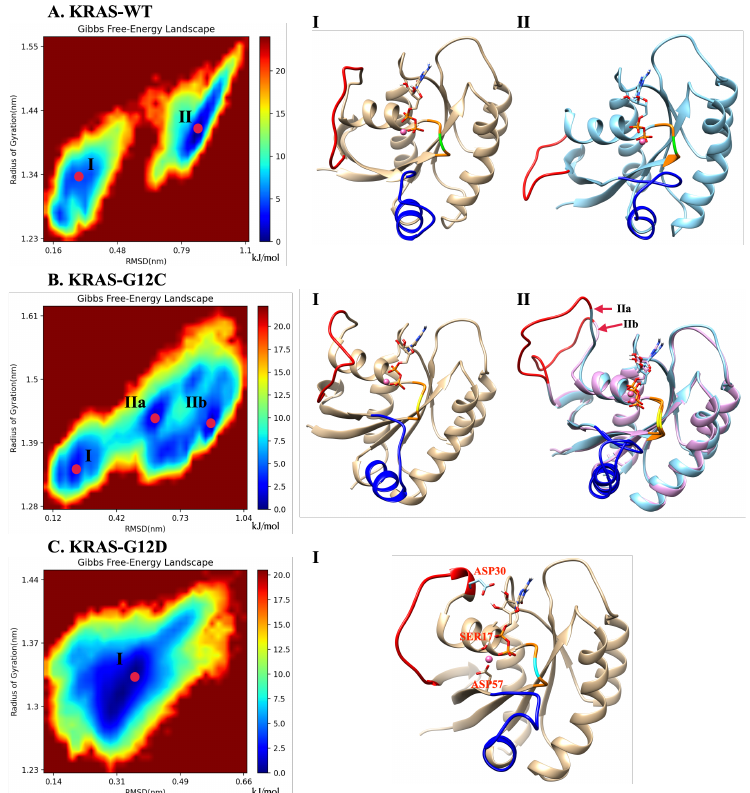
Figure 2. Gibbs free energy landscapes and representative conformations: ( A ) landscapes of the KRAS-WT-GDP-Mg 2 + complex and the representative dominant conformations of basins I and II; ( B ) landscapes of KRAS-G12C-GDP-Mg 2 + complex and the representative dominant conformations of basins I and II; ( C ) landscapes of the KRAS-G12D-GDP-Mg 2 + complex and the single representative dominant conformation (I). Selected groups: backbone atoms of residue 10 to 72; GDP and the Mg 2 + binding on KRAS. Red: SW-I; Blue: SW-II; Orange: P-loop; Green: GLY12; Yellow: CYS12; Cyan: